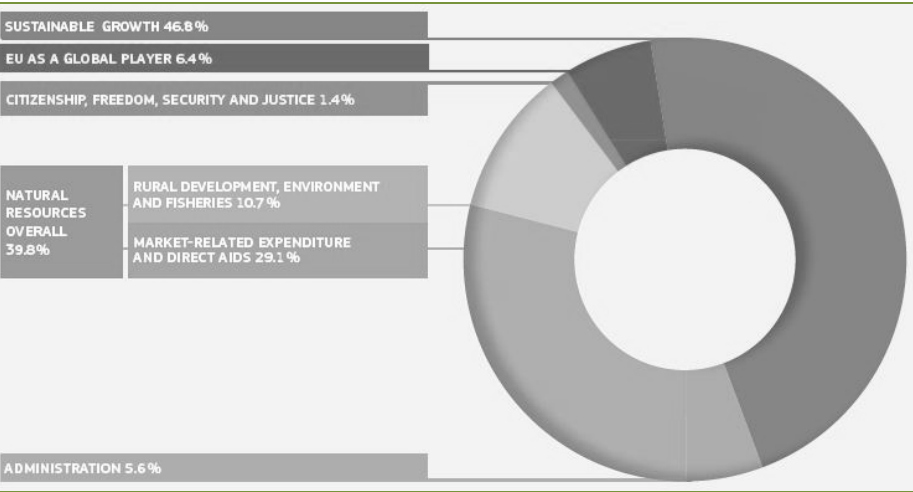
Figure 1: EU budget